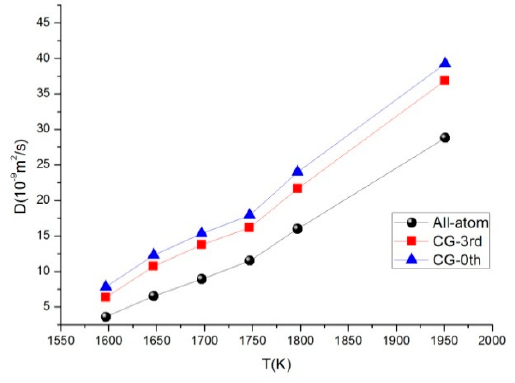
Figure 9. The temperature dependence of the diffusion coefficient of C60 in different models. Table 4. The self-diffusion coefficients using the Green–Kubo formula as compared to all models. D (10 − 9 m 2 /s) T (K) ρ (g/cm 3 ) All-Atom